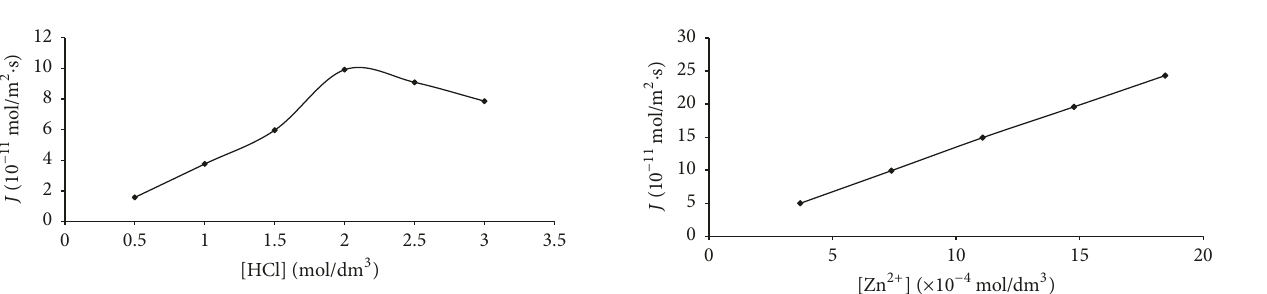
Figure 6: Effect of Zn (II) concentration in feed solution on its flux. [Zn(II)] in feed = 3.692 × 10 −4 mol/dm 3 to 18.463 × 10 −4 mol/dm 3 , [HCl] in feed = 2.0 mol/dm 3 , [NaOH] in stripping solution = 2.0 mol/dm 3 , [TDDA] in membrane phase = 0.80 mol/dm 3 , time = 5.0 h.